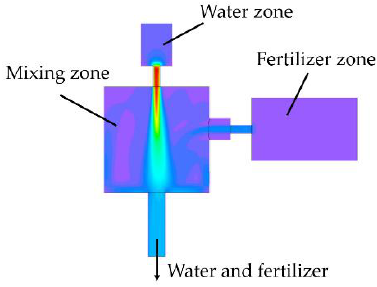
Figure 10. Simulated velocity contours in the model domain ([25], adopted from “Development of a liquid-jet nozzle for fertilizer injection in paddy fields using CFD” with permission from Elsevier, 2022).